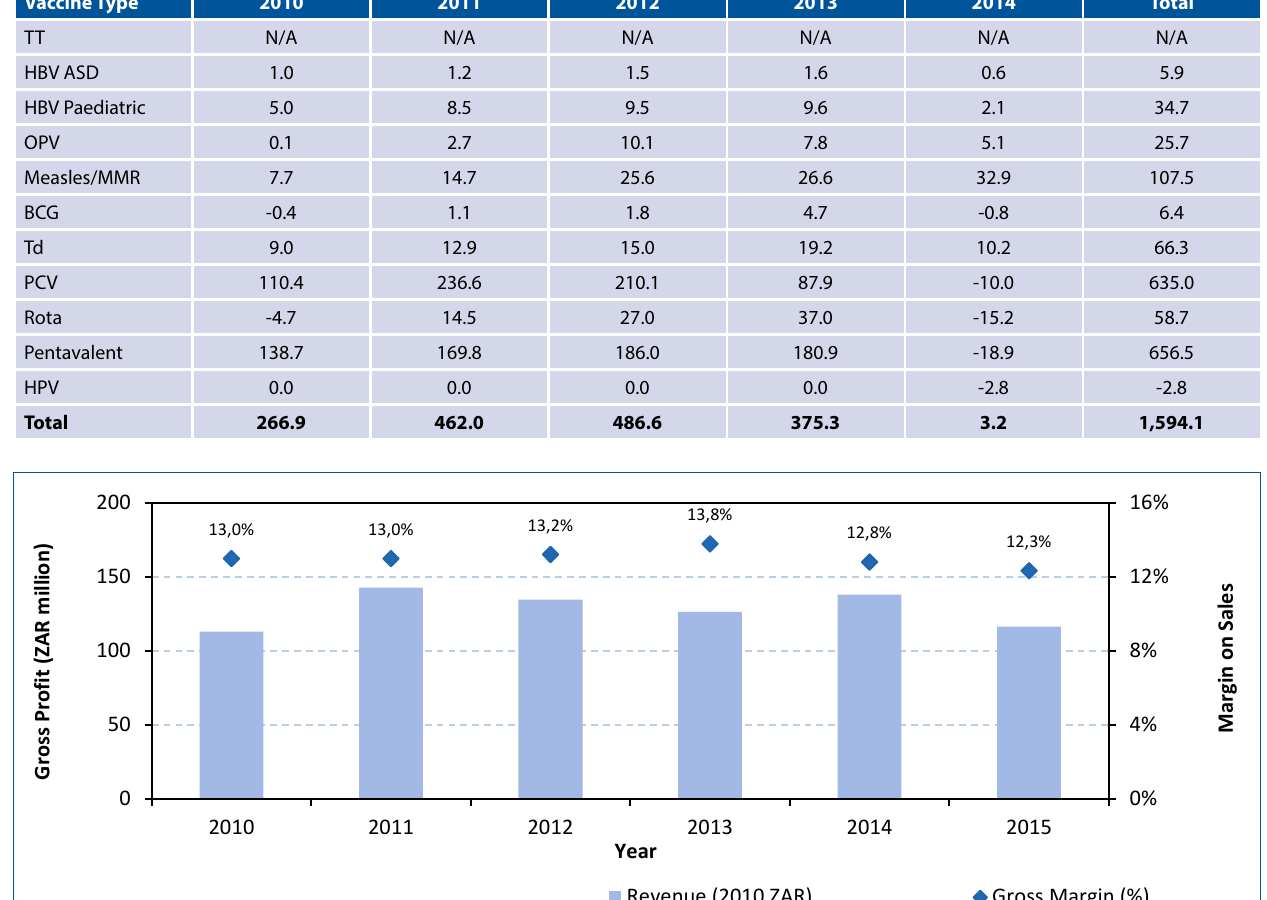
Figure 3. Gross profit and margin over the evaluation period